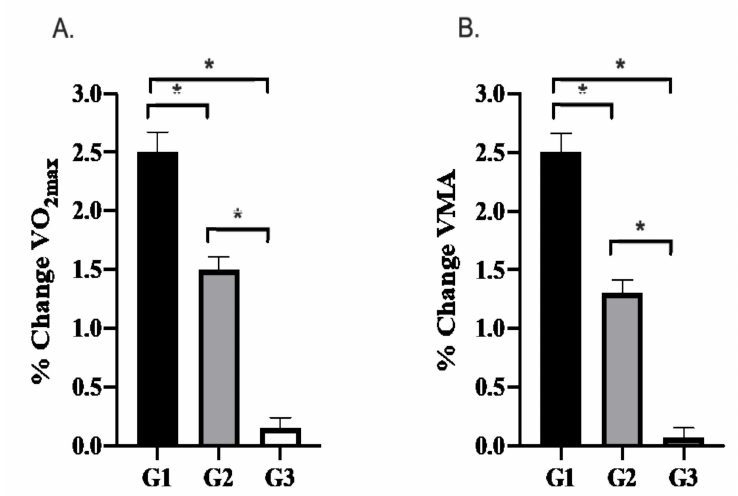
Figure 1. The relative change (pre-post) in ( A ) VO 2max and ( B ) VMA following 21-days of training at altitude (G1), seaside (G2), and sea-level (G3). Values displayed are the means ± SD. Significant differences ( p < 0.05) between training camps are denoted as